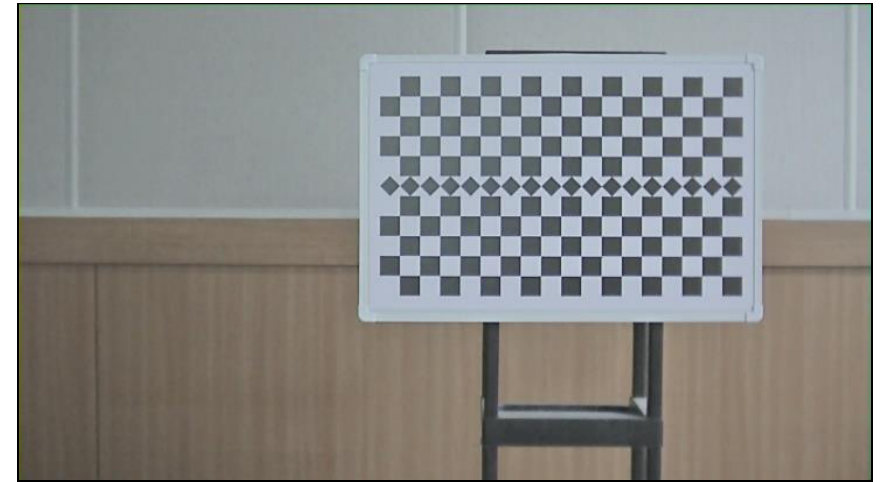
Figure 14. Proposed calibration board used in the experiment.